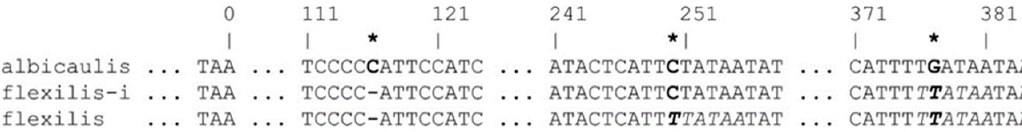
Figure 2. Restriction enzyme digests of whitebark ( Pinus albicaulis , lanes 2697 to 2867) and limber pine ( Pinus flexilis , lanes 2693 to 2667) PCR amplicons. The 12 lanes in each of the three panels represent the same DNA sample. The left-hand lane in each panel represents a 100 bps DNA ladder. Subsequent lanes are labeled by the DNA isolate number, from 2697 to 2667, the information for which is reported in the Supplemental Table S1.